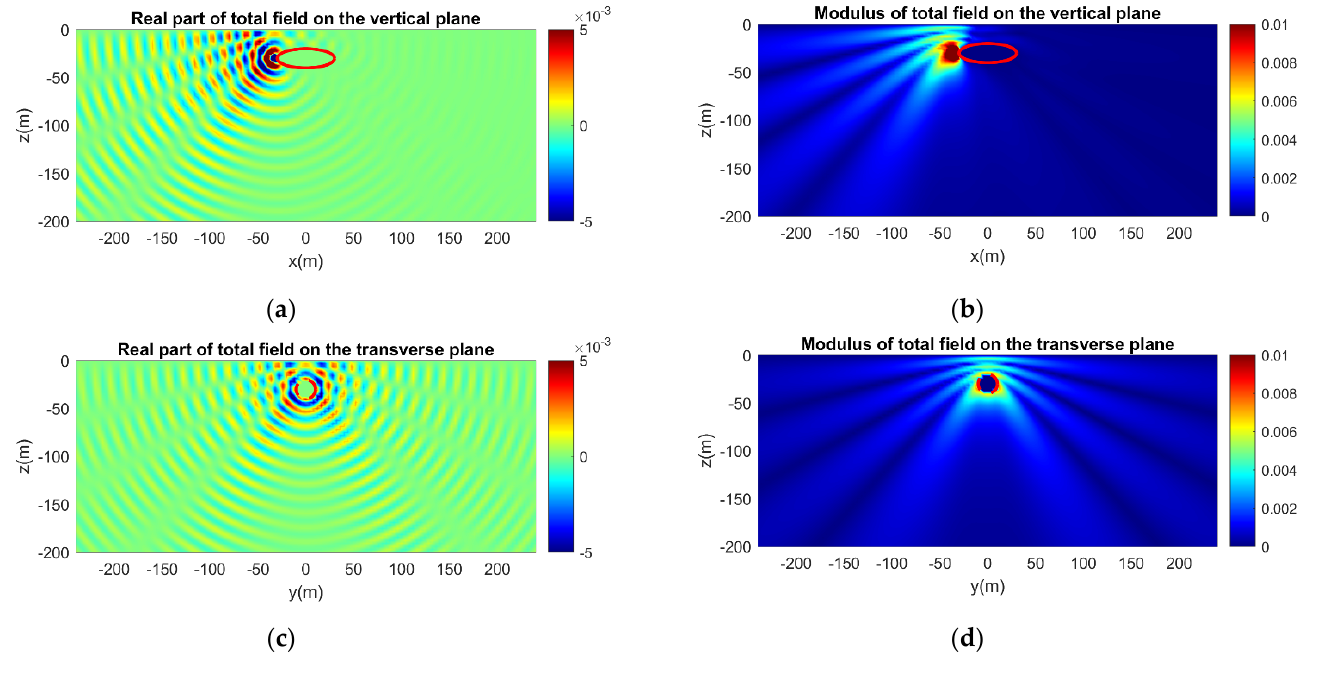
Figure 13. Calculated acoustic field in the semi-infinite ocean waveguide considering scattering of a monopole source field by an acoustically soft ellipsoid. ( a ) Real part and ( b ) modulus of the acoustic field on the vertical plane. ( c ) Real part and ( d ) modulus of the acoustic field on the transverse plane.